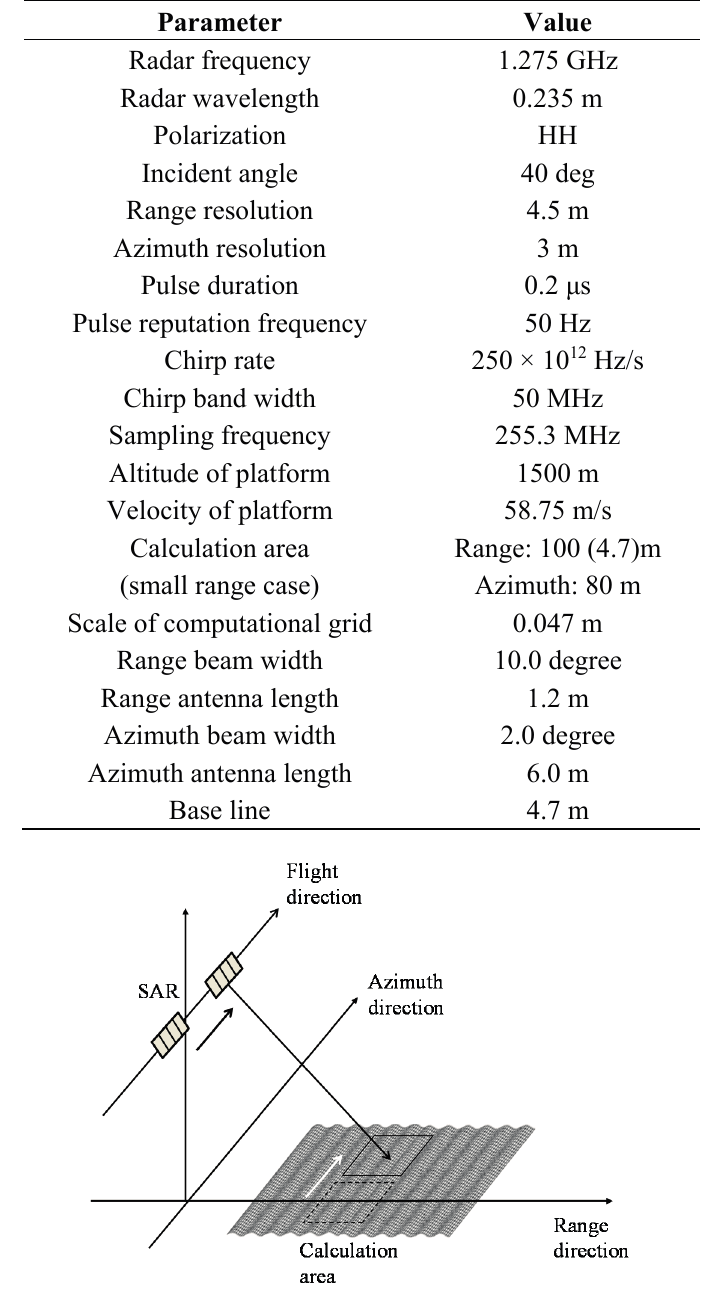
Figure 4. Schematic illustrations of azimuth signal simulations for numerical wave